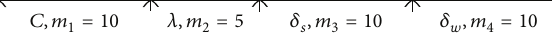
Figure 4: The structure of